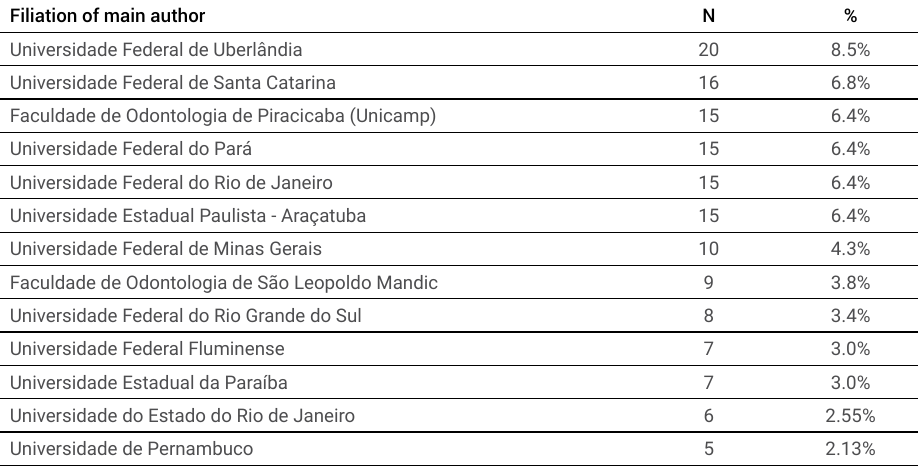
Table 1. Characteristics of included